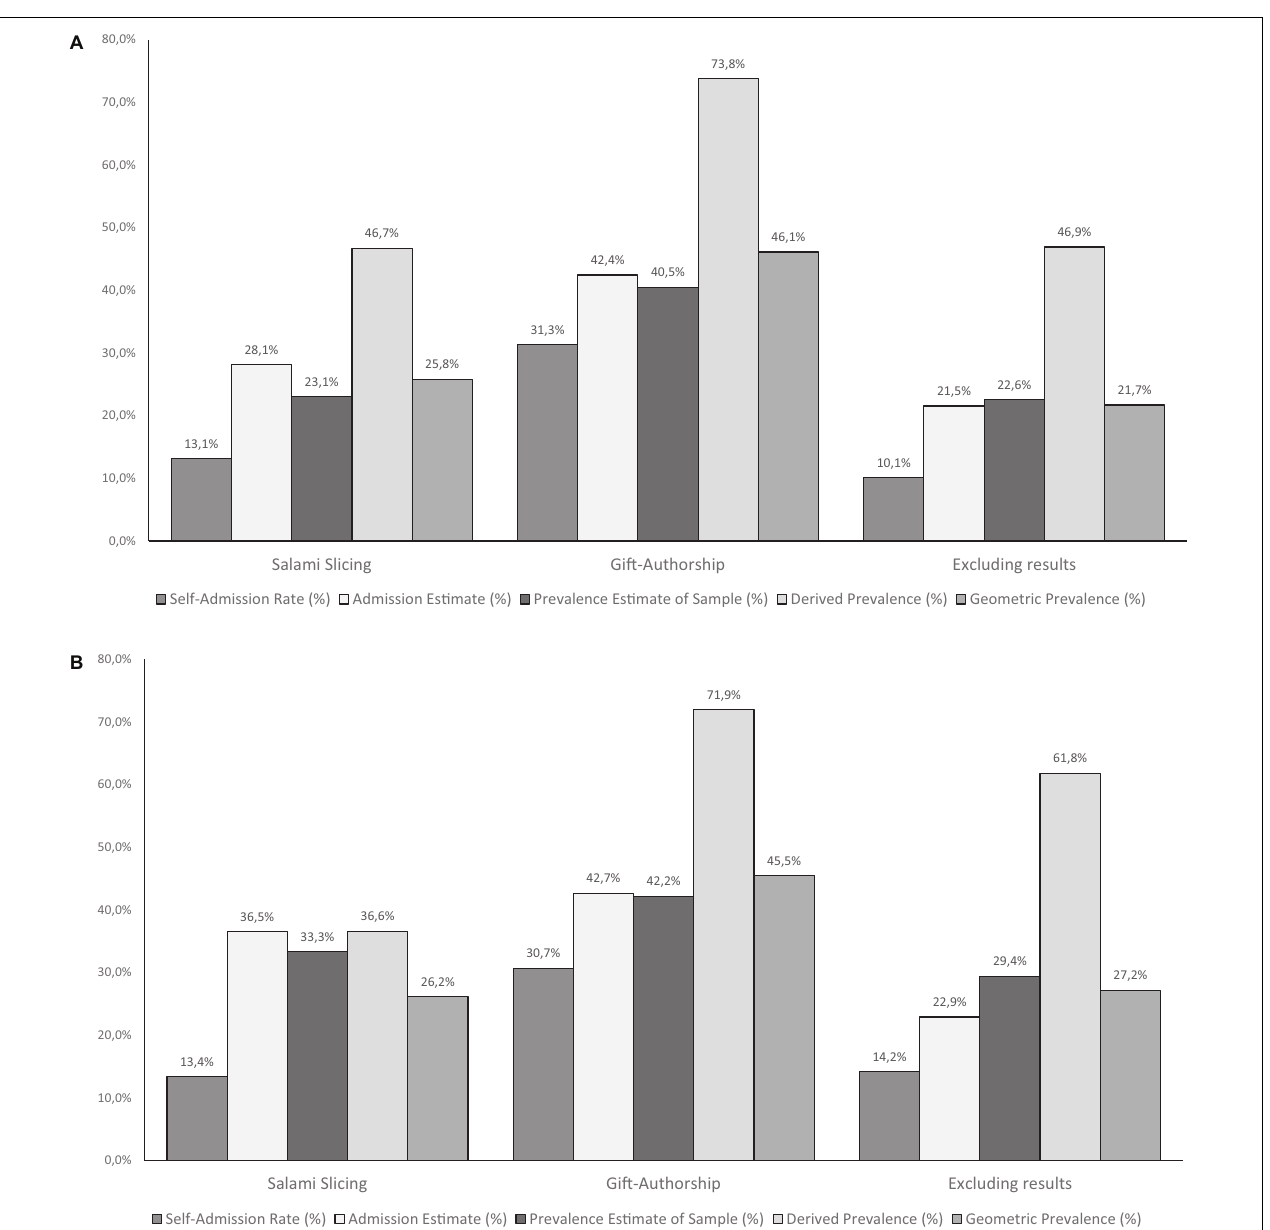
FIGURE 5 | Bayesian truth serum Results of Study 3 (A) and Study 4 (B)